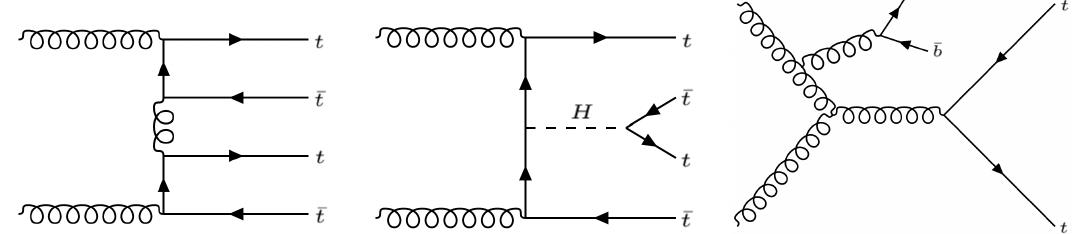
Figure 1 . Examples of tree-level Feynman diagrams for SM t ¯ tt ¯ t signal (left and middle) and one of the main backgrounds, tt production in association with b -jets